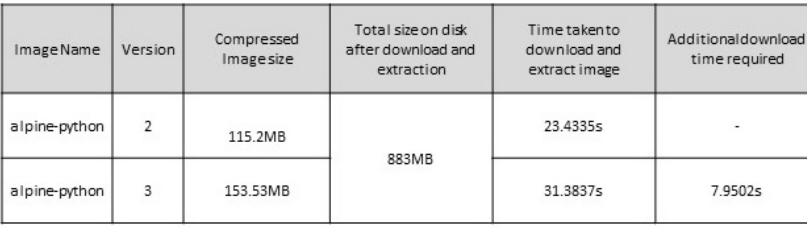
Figure 7. Image Download, Extraction Times and Storage Requirements.